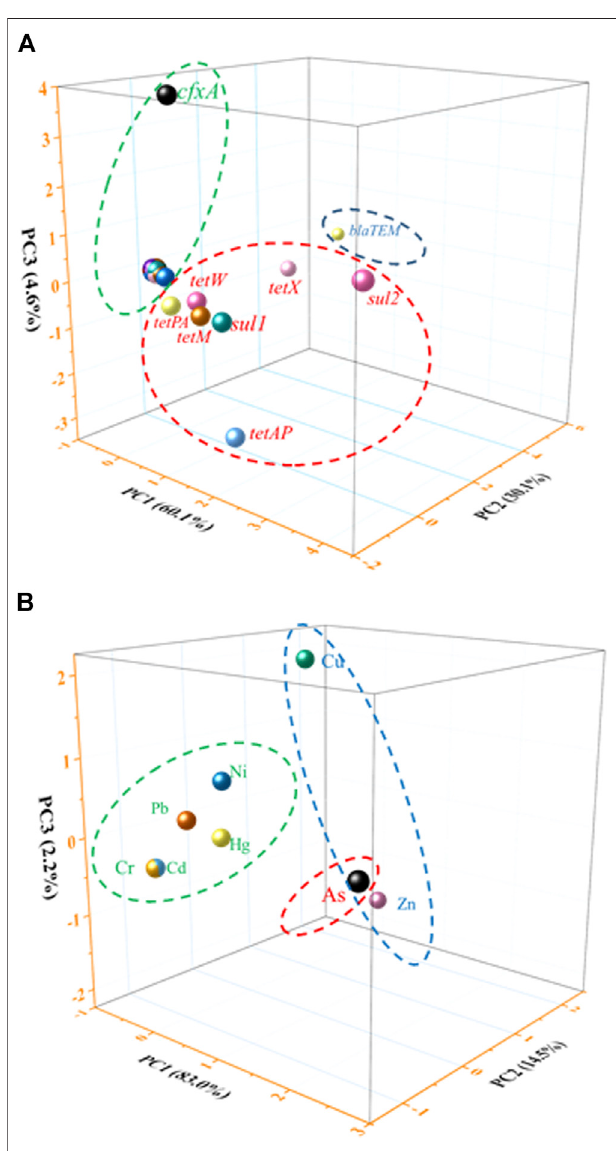
FIGURE 3 | The PCA analysis of the ARGs and heavy metals in the soil. (A) ARGs results and (B) heavy metals results.